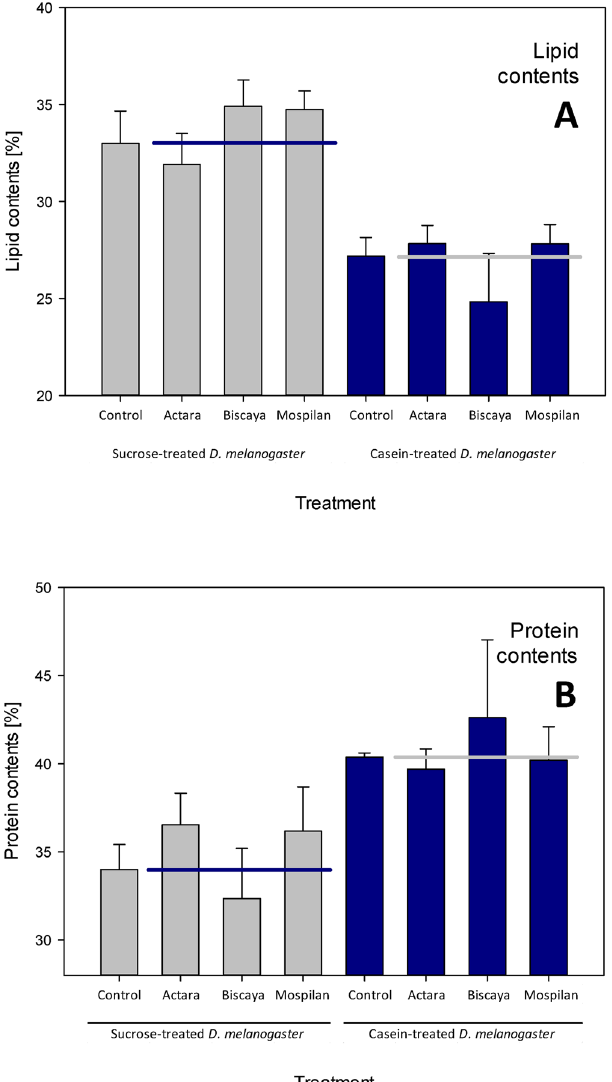
Figure 1. Macronutrient composition of spider bodies following dietary intervention and treatment with neonicotinoid insecticides. ( A ) Lipid contents. ( B ) Protein contents. Horizontal lines indicate mean control